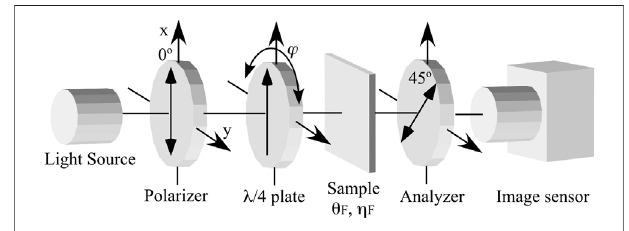
FIGURE 12 | Schematic drawings of MO microscopes using a quarter wave plate and an